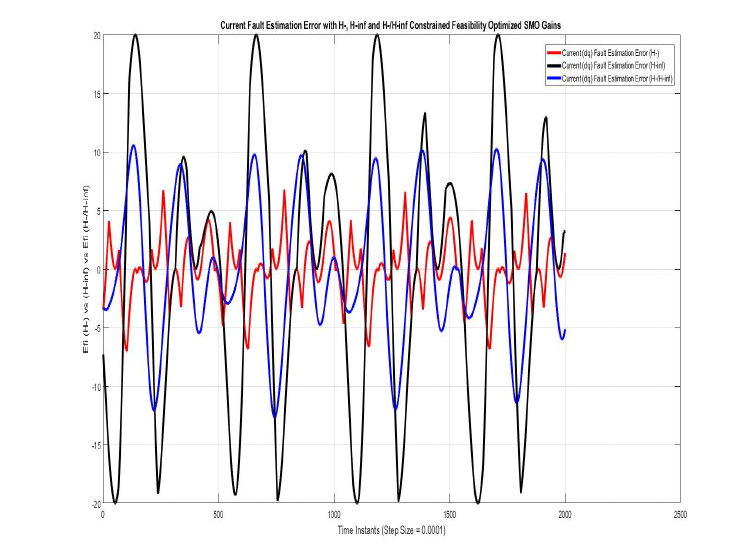
Figure 7. Current fault estimation error with feasibility optimized H − and H − / H ∞ SMO